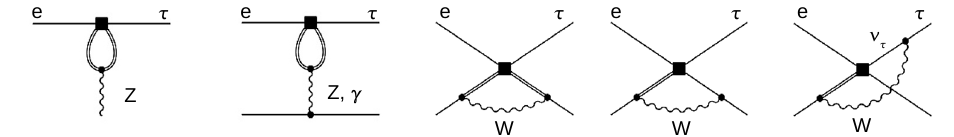
Figure 1 . One loop diagrams contributing to the running of heavy flavor operators onto operators that can be tested at the EIC and in τ decays. Plain lines denotes leptons and light quarks, double lines heavy quarks, a square an insertion of a CLFV operator and dots SM vertices. The first two diagrams represent penguin contributions of heavy flavor vector operators to CLFV Z couplings, leptonic operators and semileptonic operators with light quarks. The latter also receive contributions from W exchanges, as shown in the last three diagrams. Tensor operators run into Γ e via a diagram with the same topology as the γ,Z